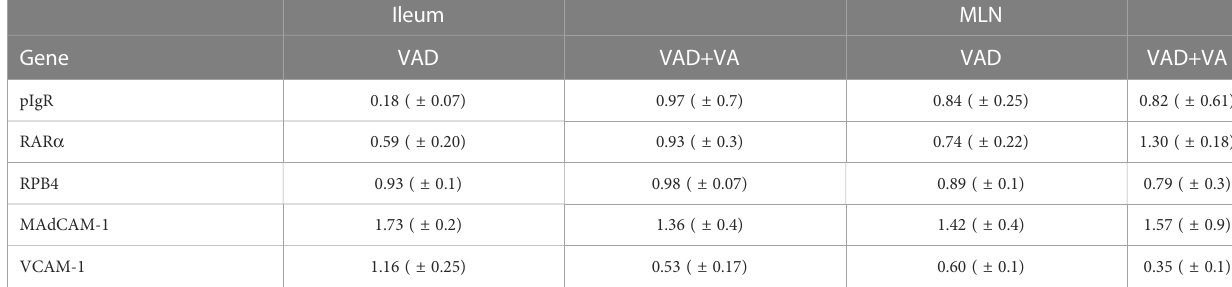
TABLE 2 Analysis of sow ileal and MLN mRNA levels of different genes by RT-qPCR relative to VAS sows at DPP~21(mean ±